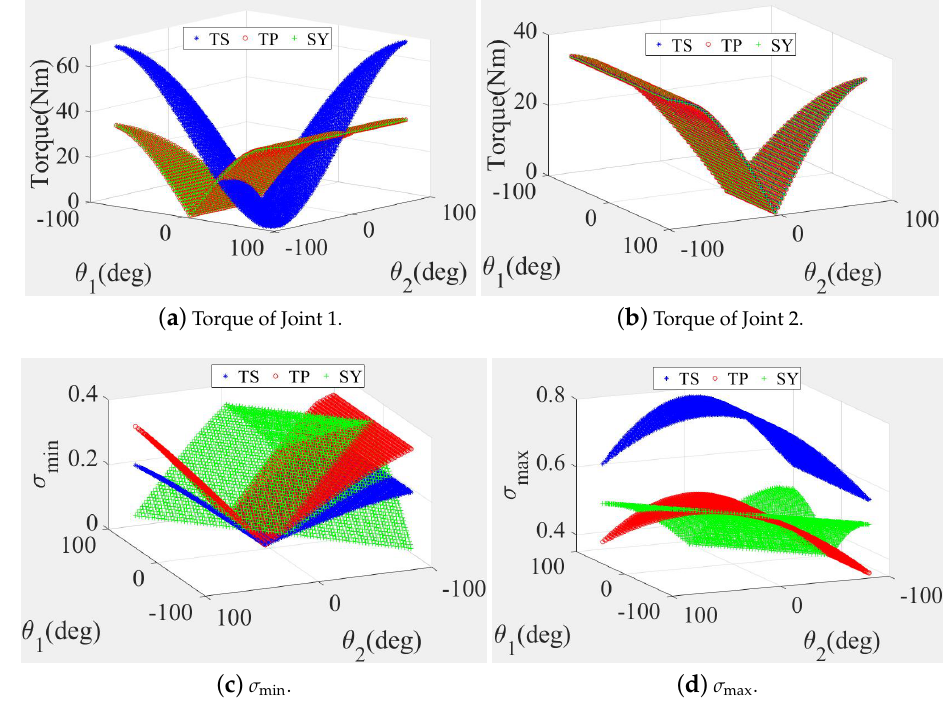
Figure 2. Joint torques and motion performance comparisons of three legs (TS, TP and SY) when L 1 = L 2